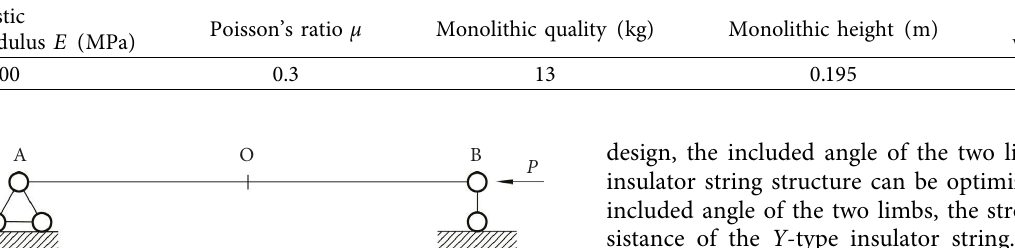
Table 3: Te parameters of the FXPW-1000/300 composite insulator.